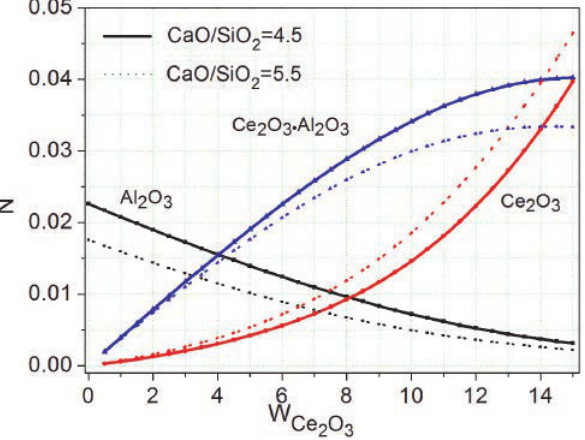
Fig. 6: The influence of the content of Ce 2 O 3 and basicity on the mass action concentrations of Ce